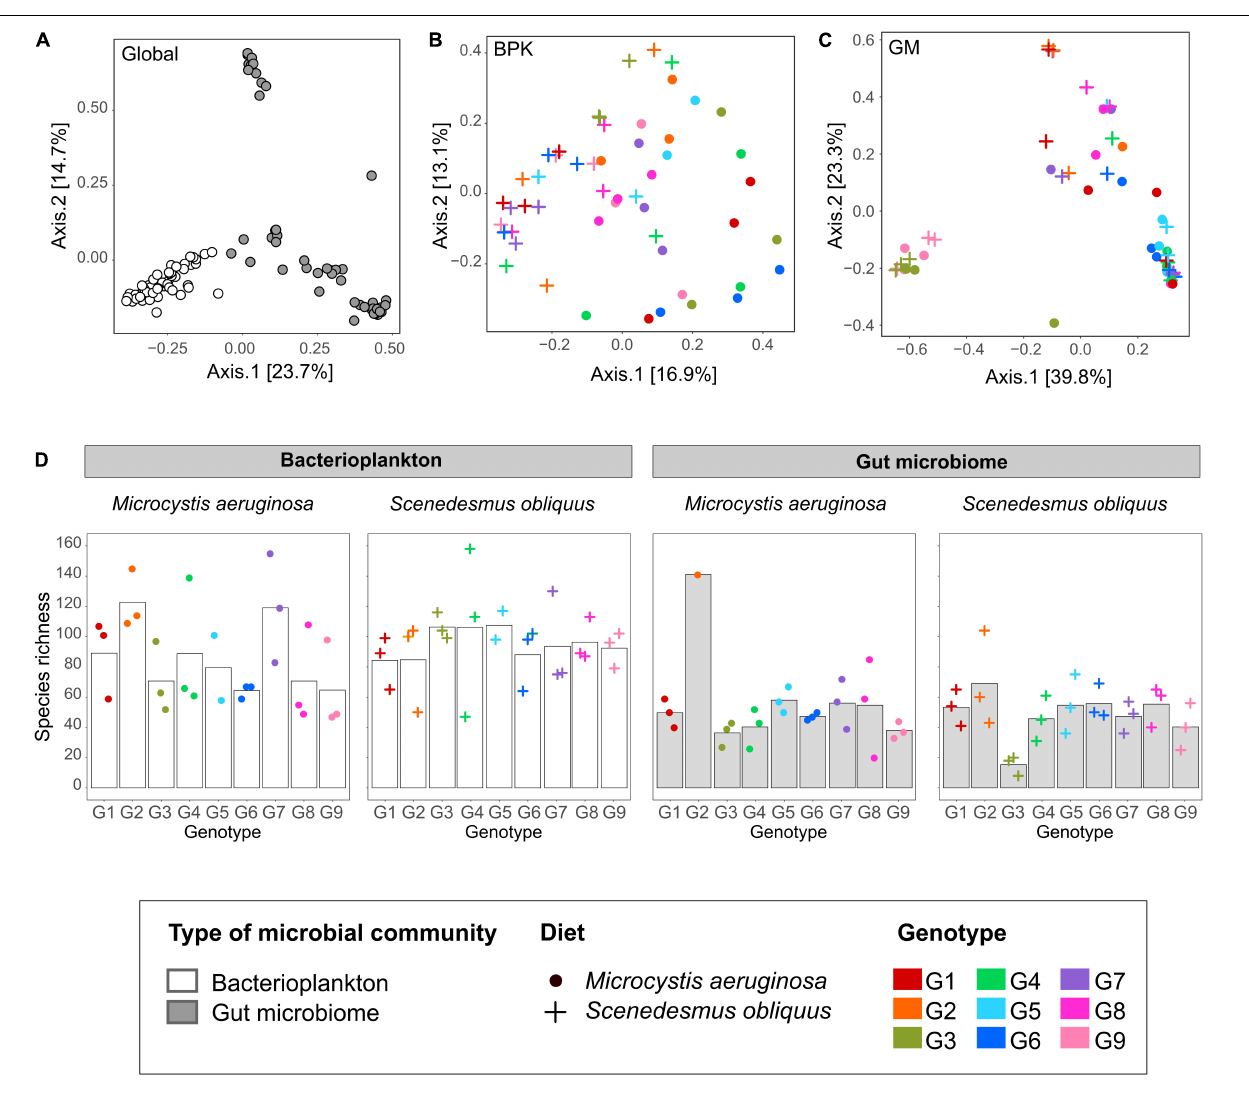
FIGURE 3 | Daphnia genotype and diet effects on GM and BPK community structure (Experiment 1). (A–C) PCoA using Bray–Curtis dissimilarity indices considering all samples simultaneously (A) , BPK samples only (B) , and GM samples only (C) . (D) α -diversity (OTU richness) in GM and BPK when Daphnia genotypes (G1–G9) were exposed to either a Microcystis or a Scenedesmus diet. Bars indicate mean values, points indicate specific values for each population.